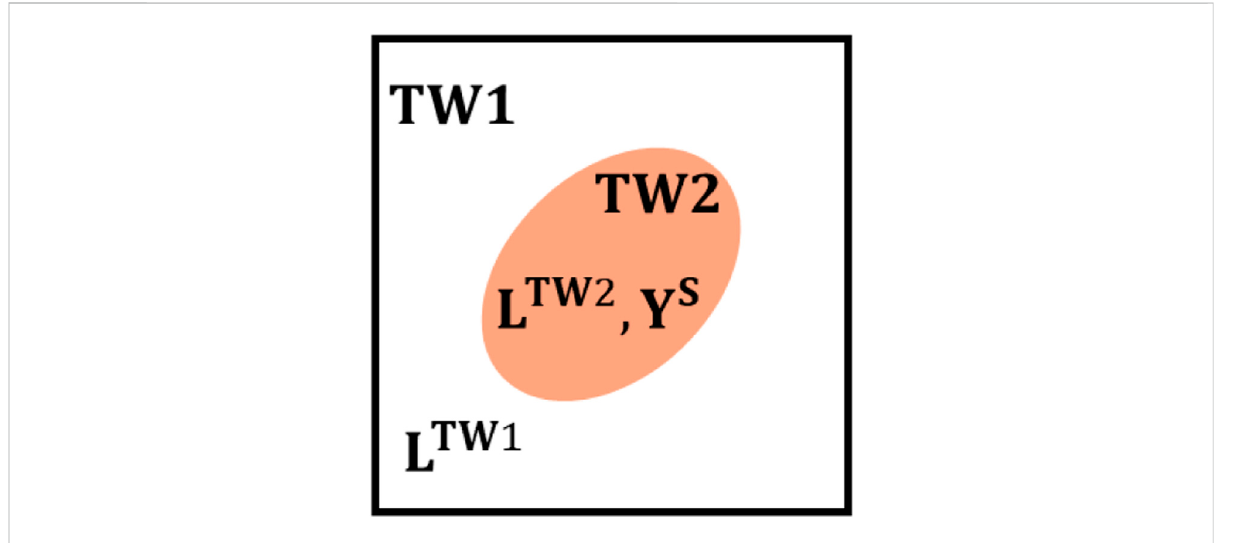
FIGURE 2 Schematic of the inhomogeneous inclusion, where TW1 and TW2 represent the unit cells in the twin structure.